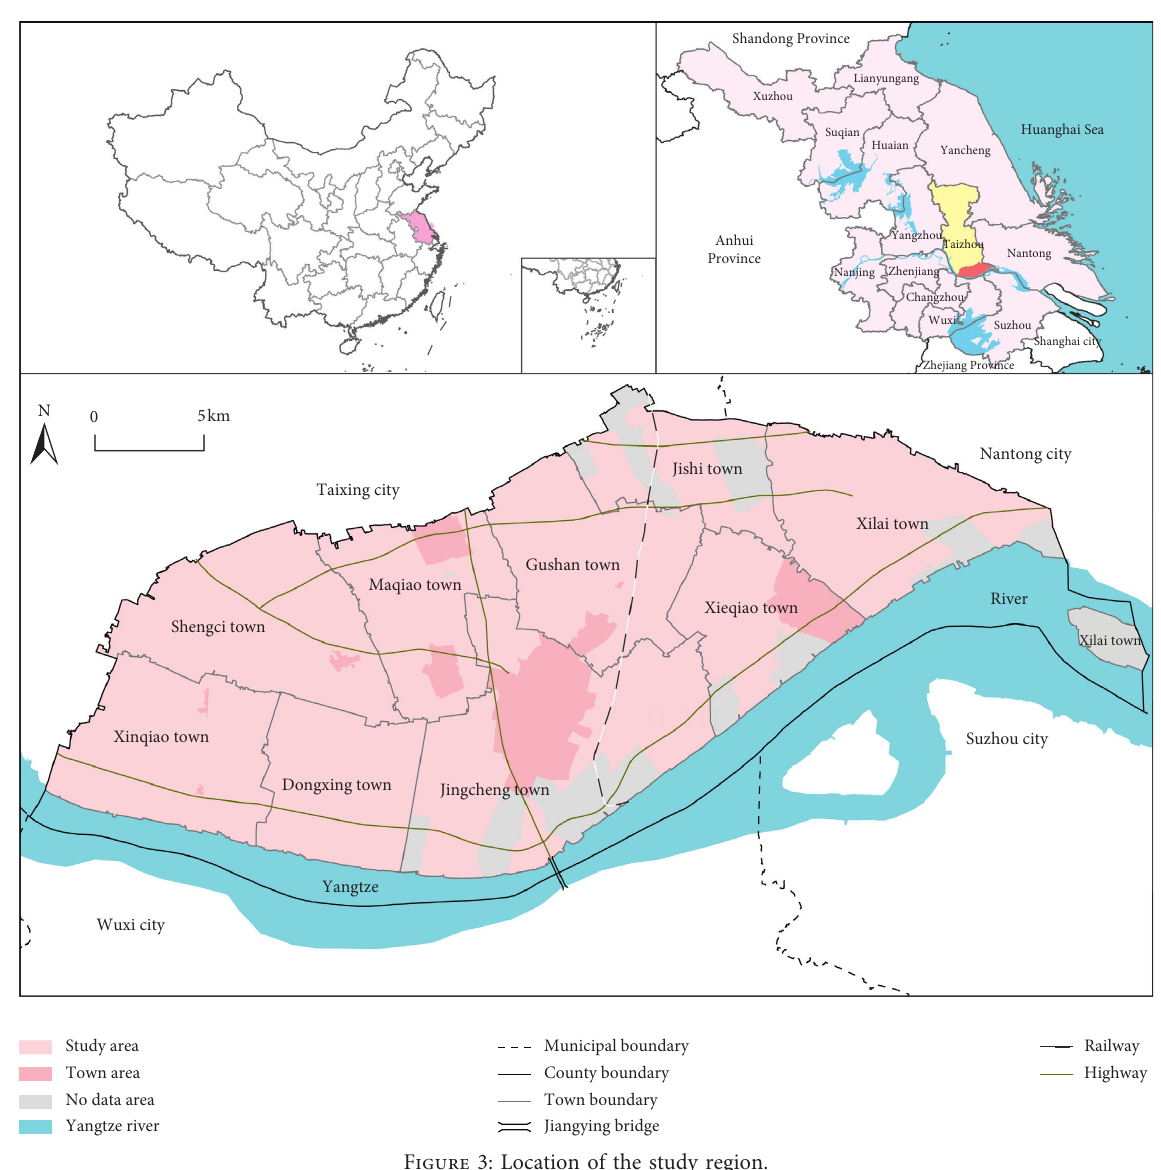
Figure 3: Location of the study